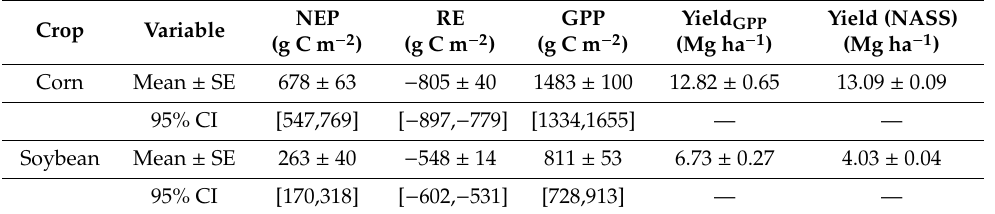
Figure 2. Meteorological data and carbon fluxes for the 2016 growing season in four Iowan counties: ( A ) Daily incoming photosynthetic active radiation (IPAR, MJ m -2 d -1 ), ( B ) daily ambient air temperature (Ta, °C), and ( C ) daytime vapor pressure deficit (VPD, kPa) averaged (± SE) over eight eddy-flux stations. In addition, ( D ) daily gross primary production (GPP, g C m -2 d -1 ), ( E ) daily net ecosystem production (NEP, g C m -2 d -1 ), and ( F ) ecosystem respiration (RE, g C m -2 d -1 ) averaged over crop (n=4); red triangles for soybean and black circles for corn. Table 2. Seasonal (DOY 145–269) NEP, RE, and GPP as well as Yield [1] and calculated Yield GPP , averaged (± SE) over four Iowa counties for corn and soybean (n = 4) in 2016.